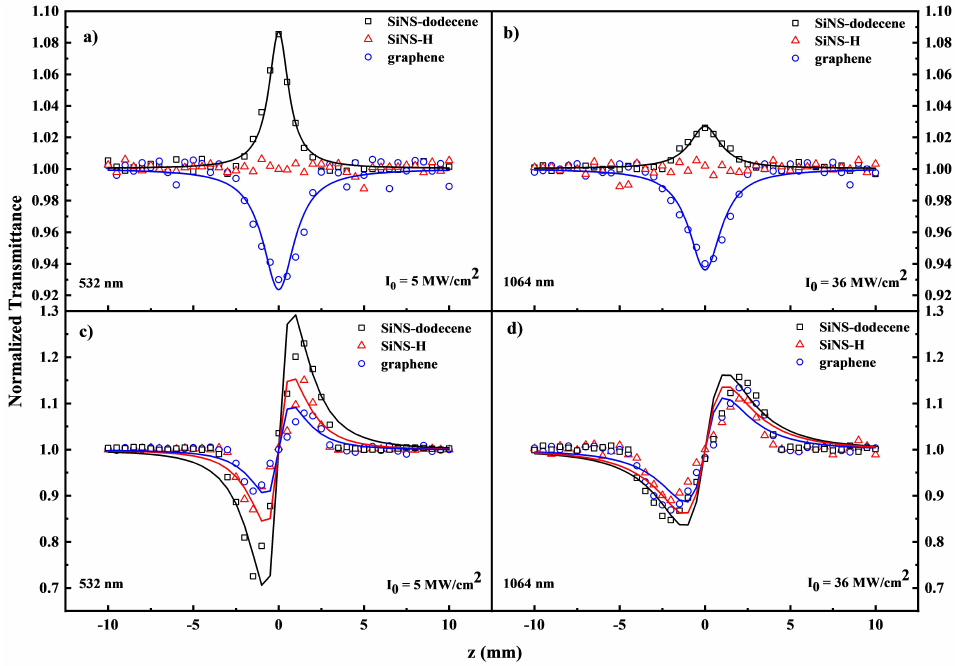
Figure 3. “Open-aperture” ( a , b ) and “divided” ( c , d ) Z-scans of SiNS–H, SiNS–dodecene, and graphene dispersions at 532 nm and 1064 nm for 4 ns. The concentration for all dispersions was 0.1